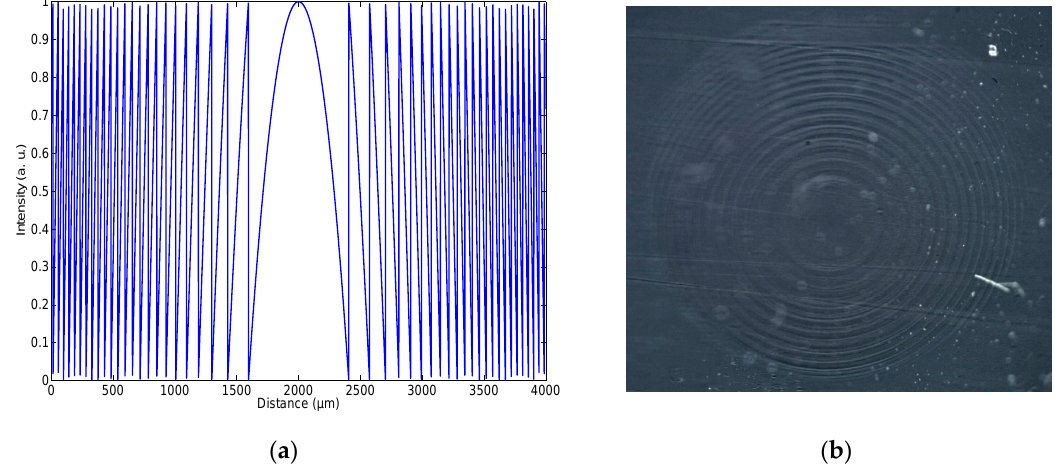
Figure 2. ( a ) Theoretical intensity distribution (horizontal cross section) sent to the liquid crystal on silicon (LCoS) for a focal length of 13 cm; ( b ) Photograph of the lens with a focal length of 60 cm recorded on material with composition 3.